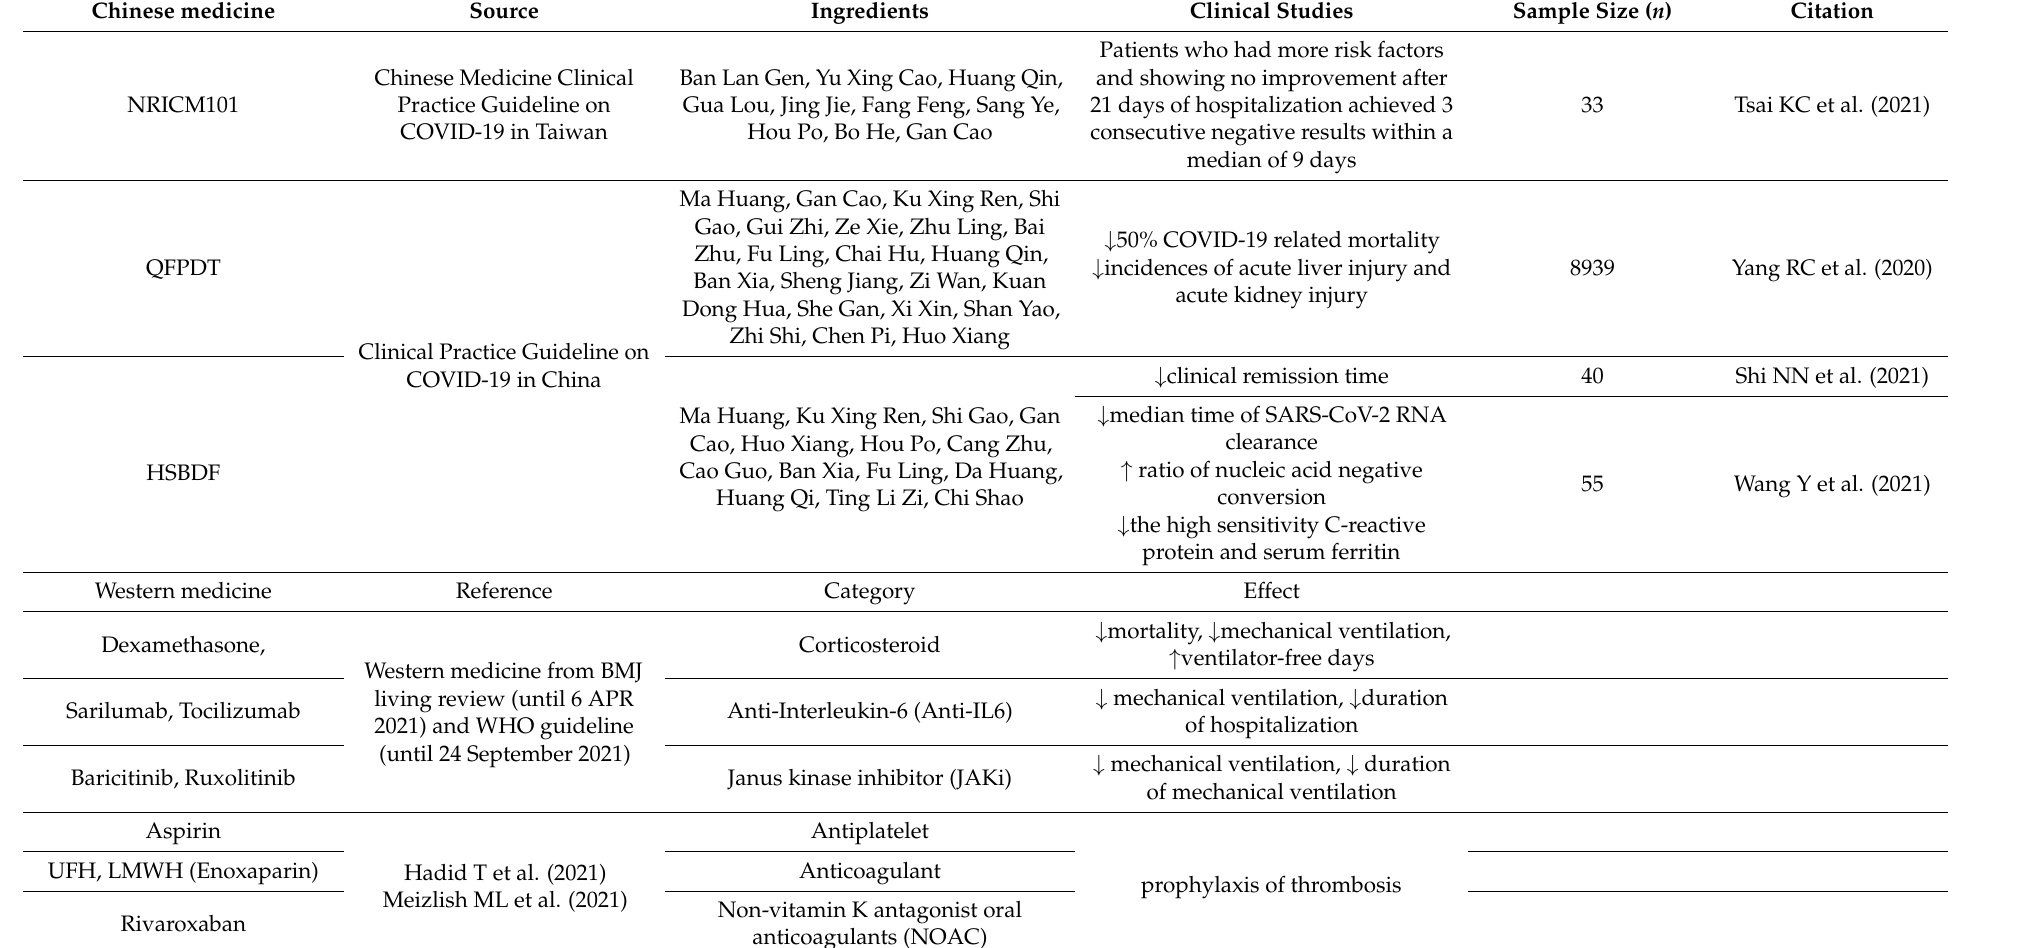
Table 1. Characteristics of the previous studies of the 3 CHM formulas and Western